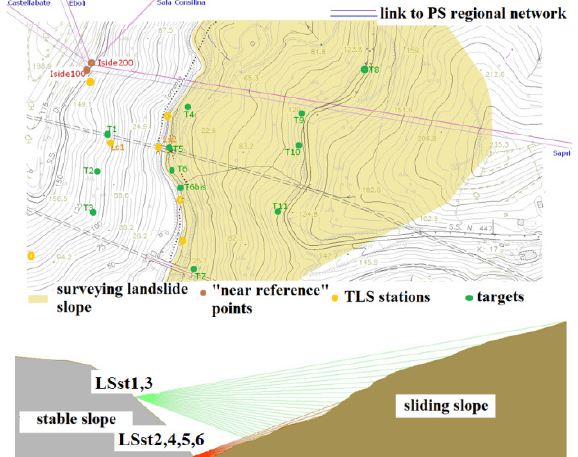
Figure 4. Planimetric e altimetric schemes of the last survey Campaign